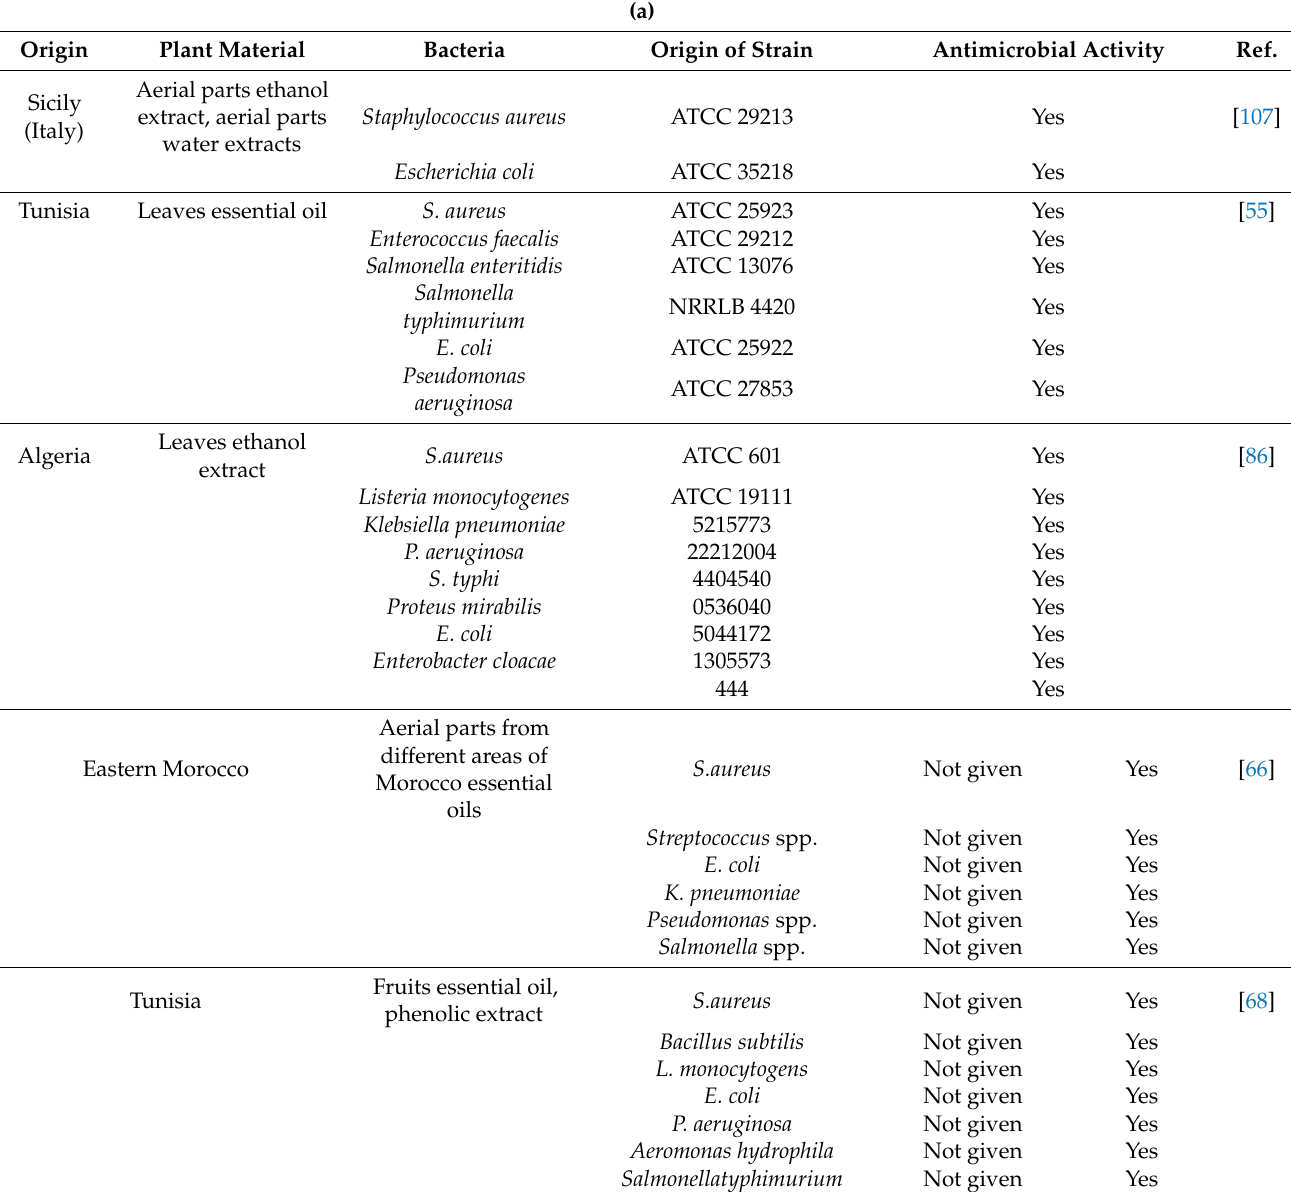
Table 5. ( a ) Antibacterial activity of Pistacia lentiscus L. determined by agar diffusion test (ADD) or minimal inhibitory concentration (MIC). ( b ) Antifungal activity of Pistacia lentiscus L. determined by agar diffusion test (ADD) or minimal inhibitory concentration